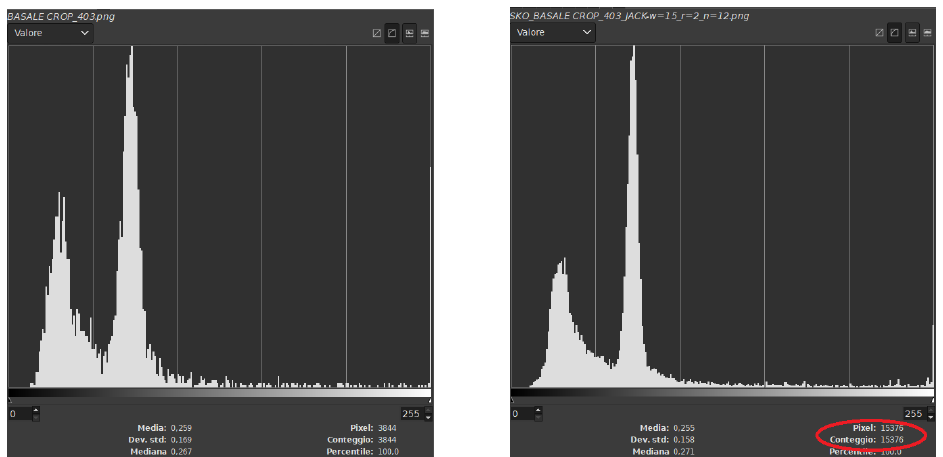
Figure 4. On the left, the histogram of the original ROI; on the right, the histogram of the ROI processed by the SK algorithm. The red circle highlights the increasing of the information content, in terms of number of